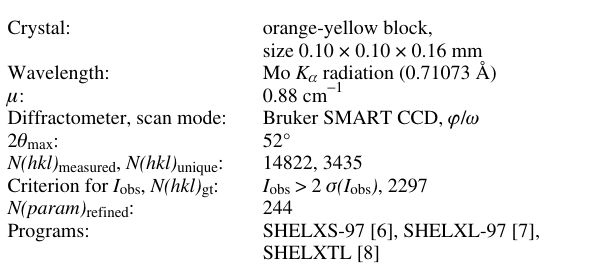
Table 1. Data collection and handling.